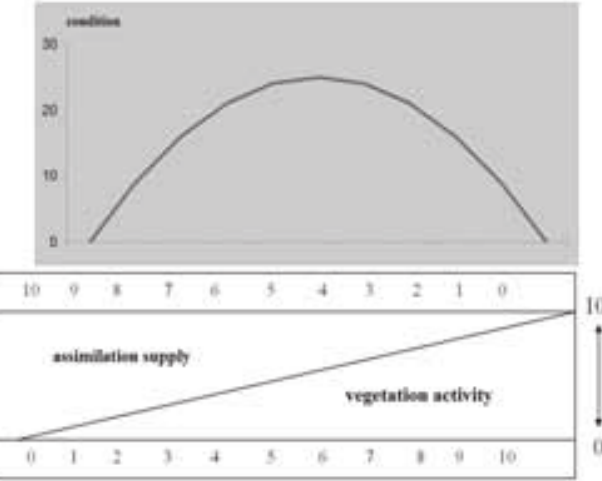
Figure 1. Optimal condition = harmony between the assimilation supply and the vegetation activity ( Zatykó ,